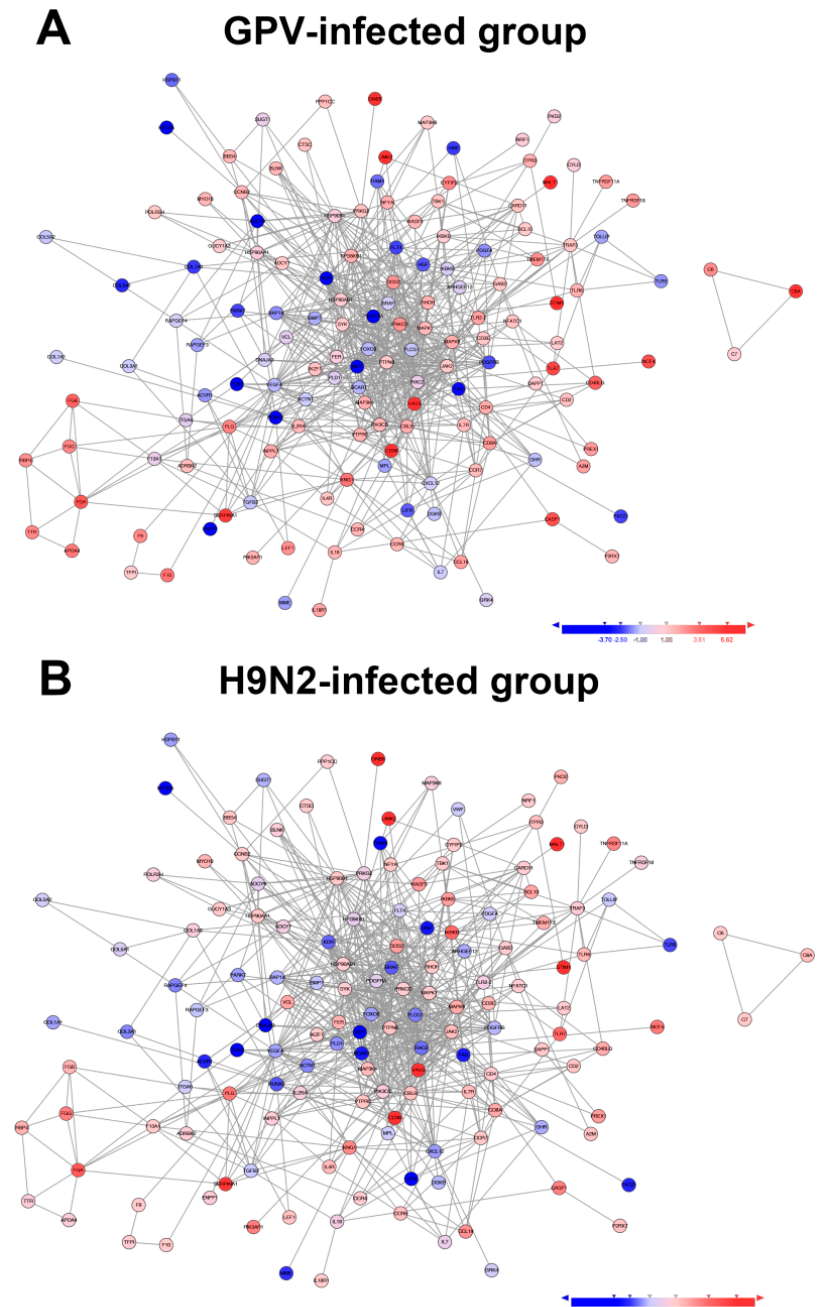
Figure 4. STRING analyses of co-immune relevant unigenes in the two virus-infected groups. All of the significant co-immune relevant unigenes were mapped to the database of the protein-protein interactions of chicken using STRING tool v9.05. ( A ) GPV-infected group; ( B ) H9N2-infected group. The expression fold change is shown as log 2 (virus/mock) and is represented as indicated in the color scale.